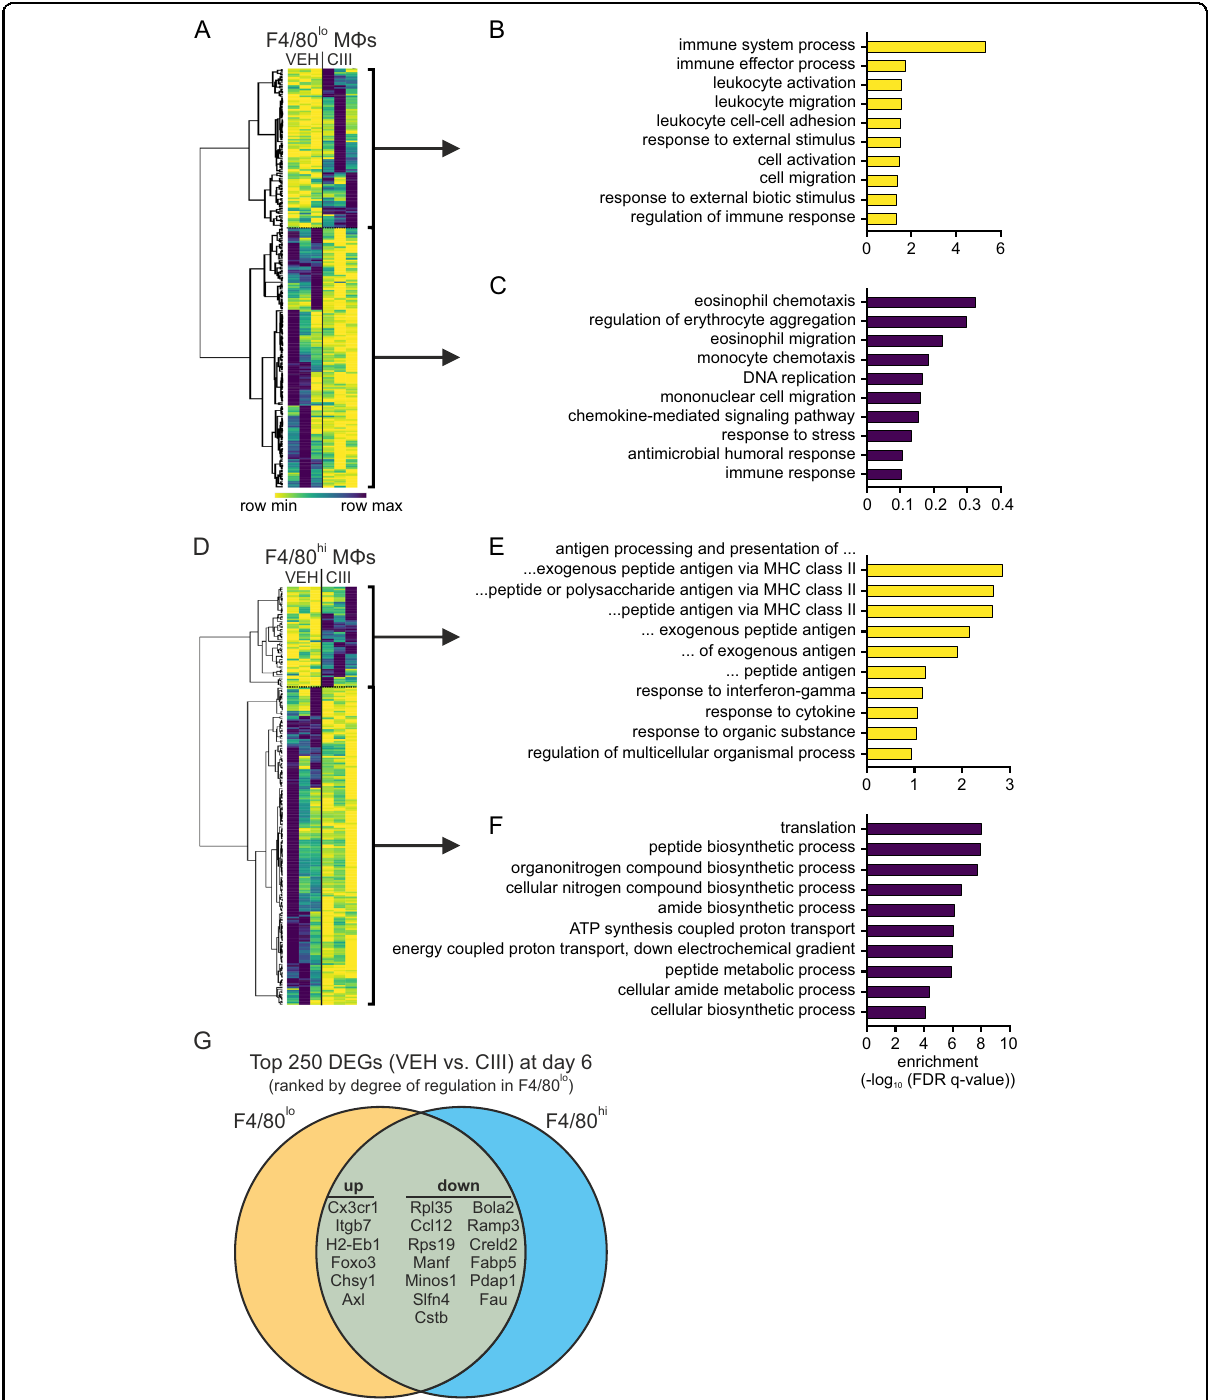
Fig. 2 Peritoneal macrophages are activated during resolution of in fl ammation upon mPGES-1 inhibition. Starting 24 h post i.p. zymosan (5 mg/kg) injection, mice received daily i.p. injections of the mPGES-1 inhibitor compound III (CIII) (25 mg/kg) or the appropriate vehicle control (VEH). F4/80 hi and F4/80 lo macrophages (M ϕ ) were FACS sorted followed by mRNA-seq analysis ( n = 3). A , D mRNA expression of the top 250 differentially regulated genes comparing VEH- and CIII-treated mice at day 6 in A F4/80 lo and D F4/80 hi M ϕ . Top ten enriched GO terms based on the hierarchical clusters of upregulated ( B ) or downregulated C DEGs from F4/80 lo M ϕ . Top ten enriched GO terms based on the hierarchical clusters of upregulated ( E ) or downregulated F DEGs from F4/80 hi M ϕ . G Venn diagram of the top 250 DEGs in F4/80 lo (orange) and F4/80 hi M ϕ (blue). Overlapping DEGs (green) are ranked according to their degree of regulation in F4/80 lo M ϕ